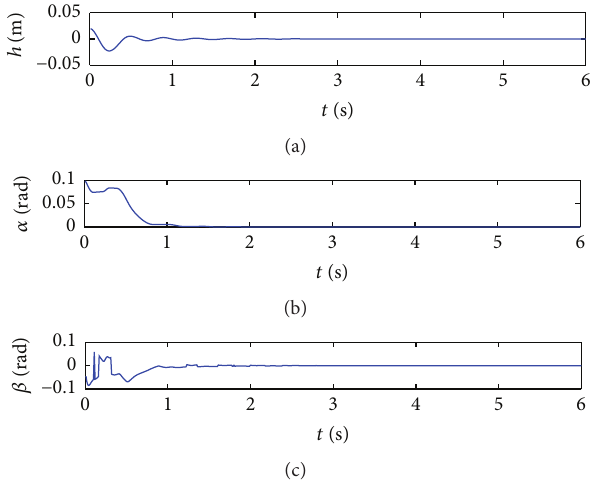
Figure 5: ILC control for triangular gust, 𝑤 0 = 2 , 𝑈 = 16 m/s: (a) plunge displacement ℎ (m); (b) pitch angle 𝛼 (rad); (c) control input 𝛽 (rad). {𝑘 } = [6.8614 7.8480 663.2887 65.2752 −4992.7944] 𝑇 . 𝑎 𝑗 The upper bounds for the uncertain parameter 𝜉 are arbitrarily selected as {𝜉 𝑥 } = [6.9614 8.8480 667.3887 68.2752 5087.7944] 𝑇 . The design parameters are given as follows: 𝑘 𝑏 = 0.35 , 𝑝 = 10 , 𝑞 = 5 , 𝜑 = 0.2 , and 𝜆 = 0.012 . The poles of the linearized uncontrolled system without external disturbance for 𝑈 = 10 m / s and 𝑎 = −0.6719 are ( −1.47 ±